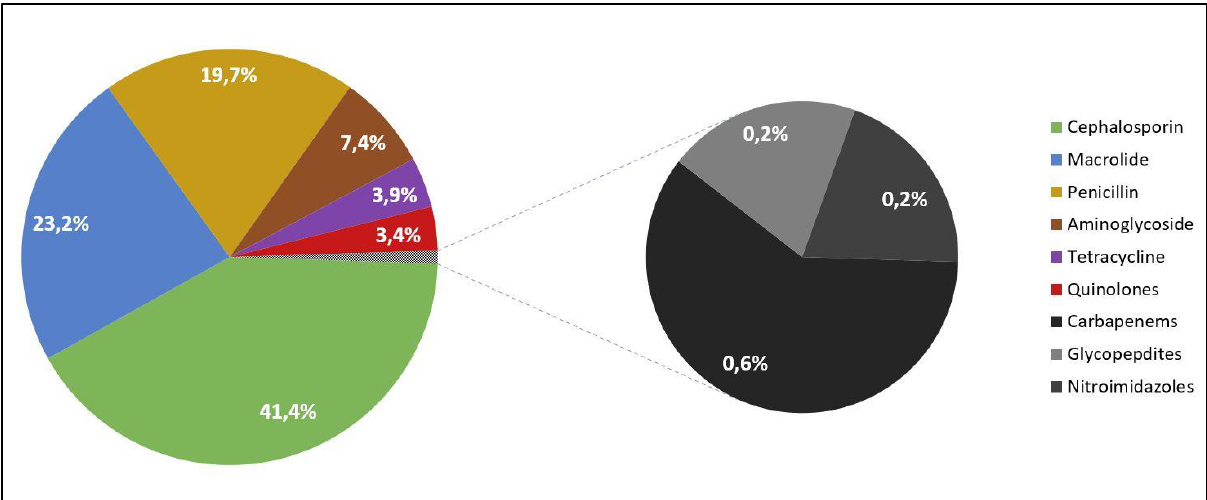
Figure 1. Frequency of self-medicated antibiotics among patients with COVID-19 and secondary bacterial infections.